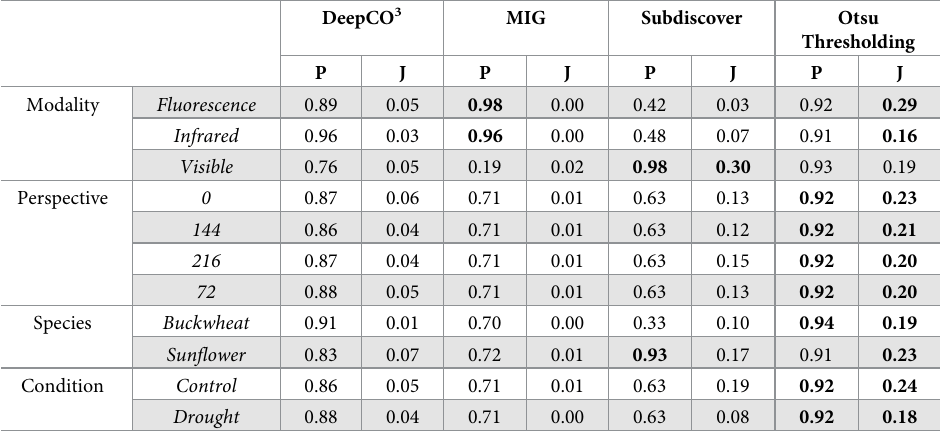
plant images have dominantly two colors (green for the plant and white for the background). As the object of interest gets smaller compared to the background area, then the histogram will no longer exhibit bimodality [40]. In summary, Subdiscover continues to demonstrate accurate segmentation for a group of images that contain variety (plant youngling to plant maturity), but only for the visible modal- ity. MIG performed similarly to Otsu thresholding in the Fluorescence and Infrared modality both demonstrating the ability to segment a group of images with multiple perspectives and temporal data. An averaging was done across each feature for all datasets in CosegPP to determine which algorithms scored the highest for Precision and Jaccard as shown in Table 7. The final sum- mary table is in Table 8. Table 7. Averages of each feature in the CosegPP data